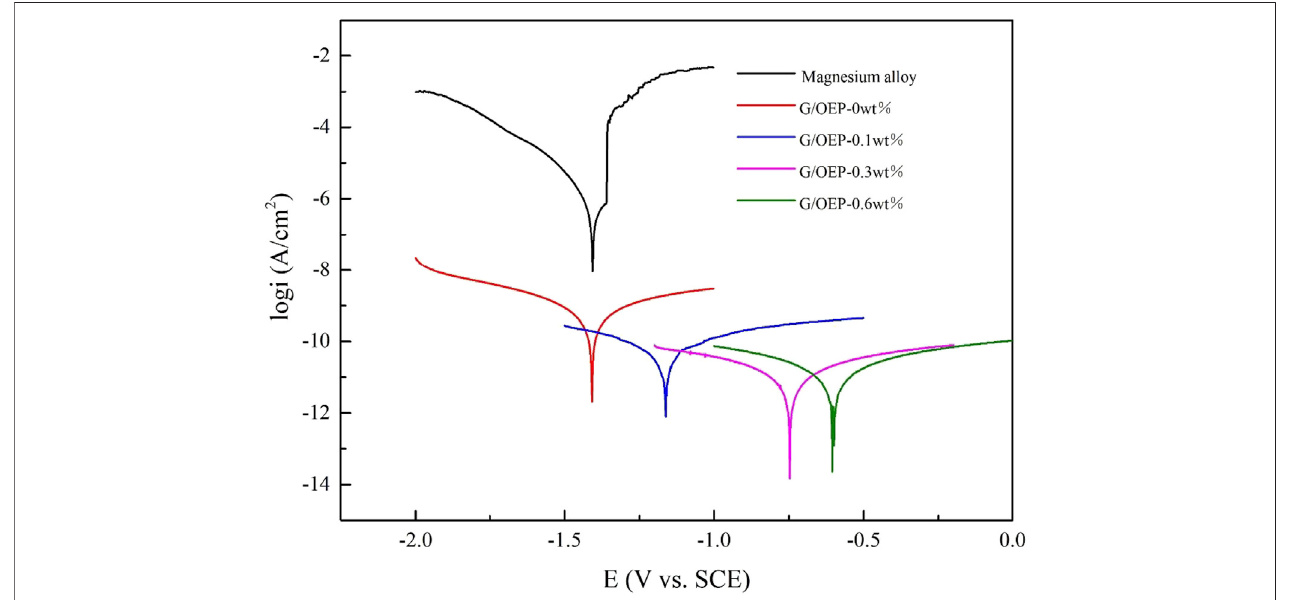
FIGURE 5 | Potential polarization curve of magnesium alloy and coating.